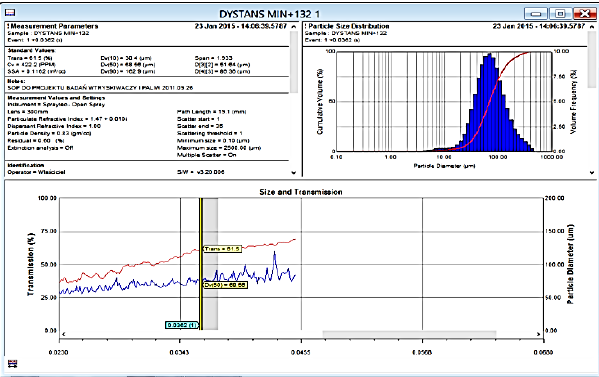
Fig. 4. Spout geometric parameters entry dialog box